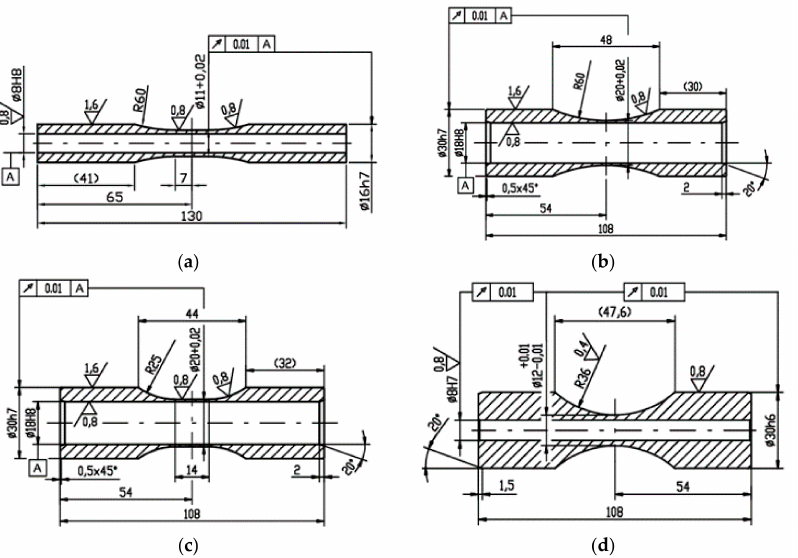
Figure 1. Drawings of specimens used in this campaign: ( a ) S1—top left, ( b ) S2—top right, ( c ) S3—bottom left, ( d ) S4—bottom